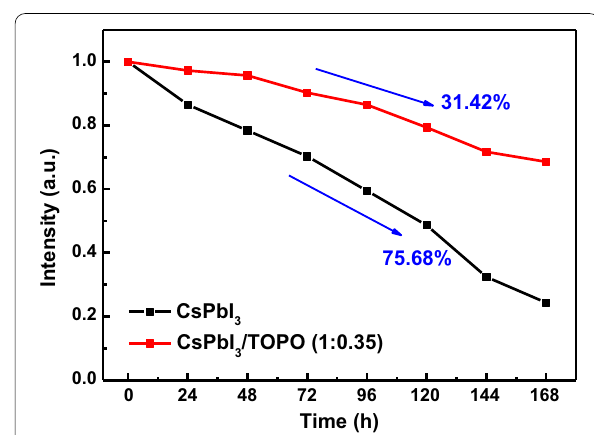
Fig. 8 Stability of CsPbI 3 ‑converted and CsPbI 3 /TOPO composite‑converted red